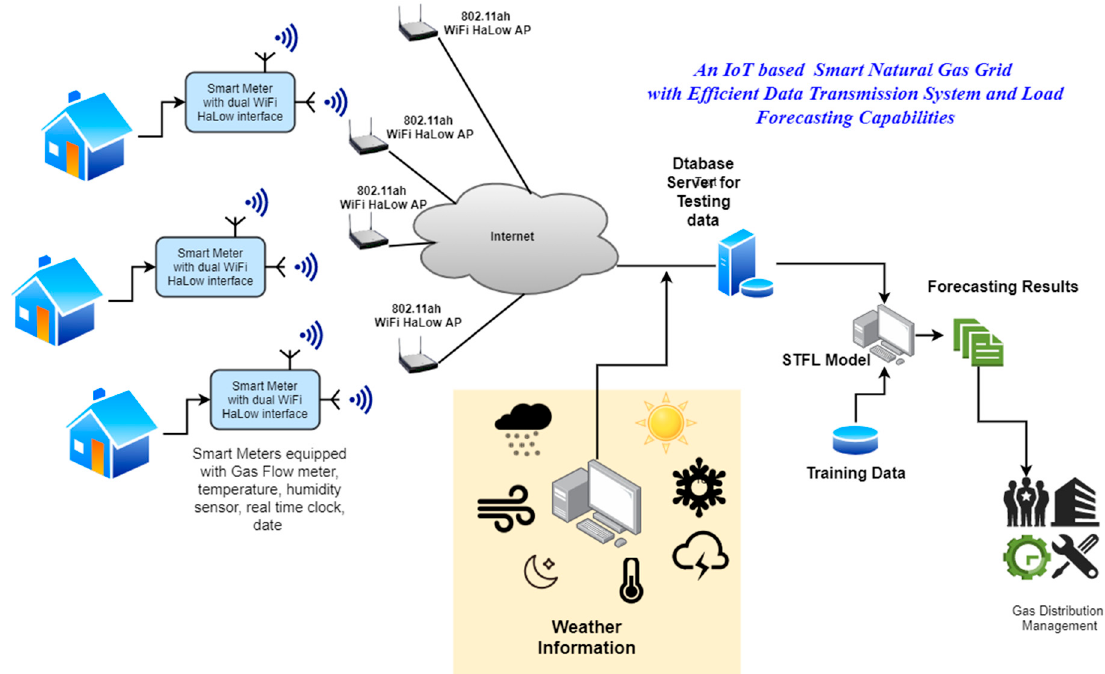
Figure 1. An Internet of Things (IoT)-based smart gas network.